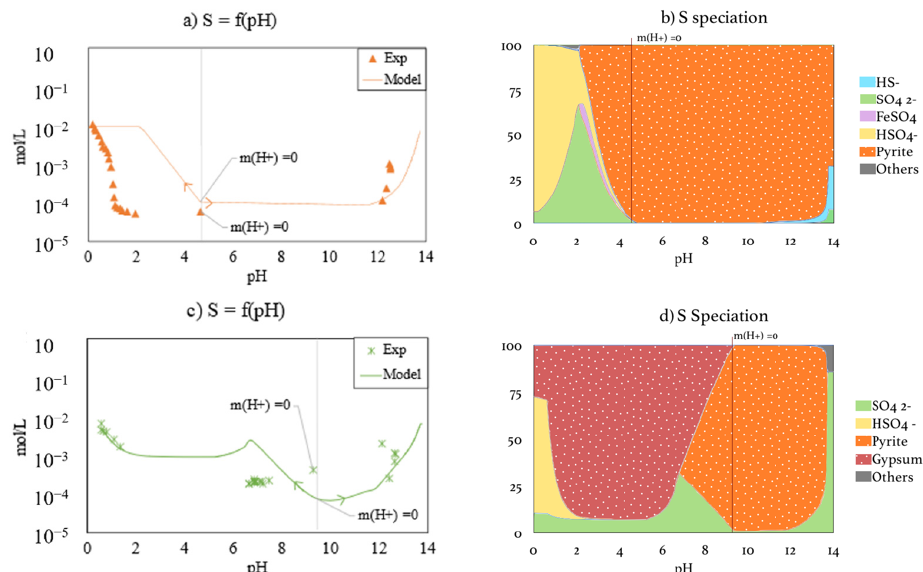
Figure 6. Total experimental soluble content and modeled speciation of sulfur as a function of pH: ( a , b ) pyrite/SiO 2 and ( c , d ) calcite/pyrite/SiO 2 . Arrows indicate the direction of addition or depletion of protons; the vertical line indicates the point of equilibrium with pure water (natural pH).